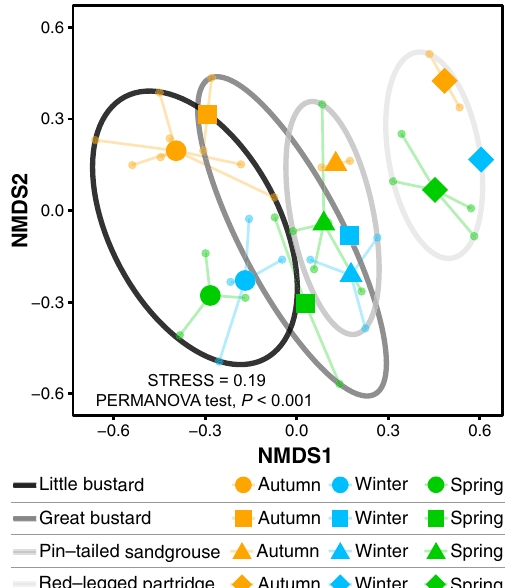
Figure 5. Graphical illustration of the NMDS base on diet OTUs of little bustard, great bustard, pin-tailed sandgrouse, and red-legged partridge represented by season. Large symbols represent the centroid of the flocks of each species in each season, while small dots represent data of each different flock per species and season. The circles group data of each